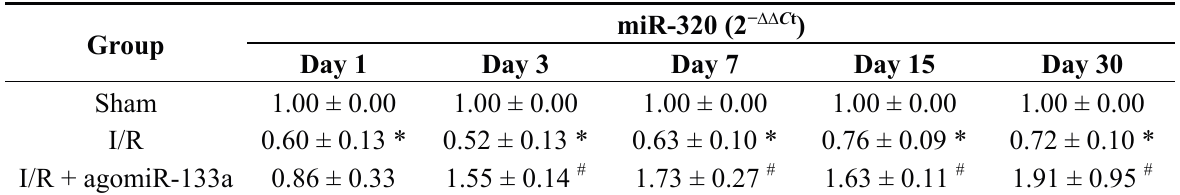
Table 4. Expression of miR-320 in the myocardial tissue of three groups at five time points.